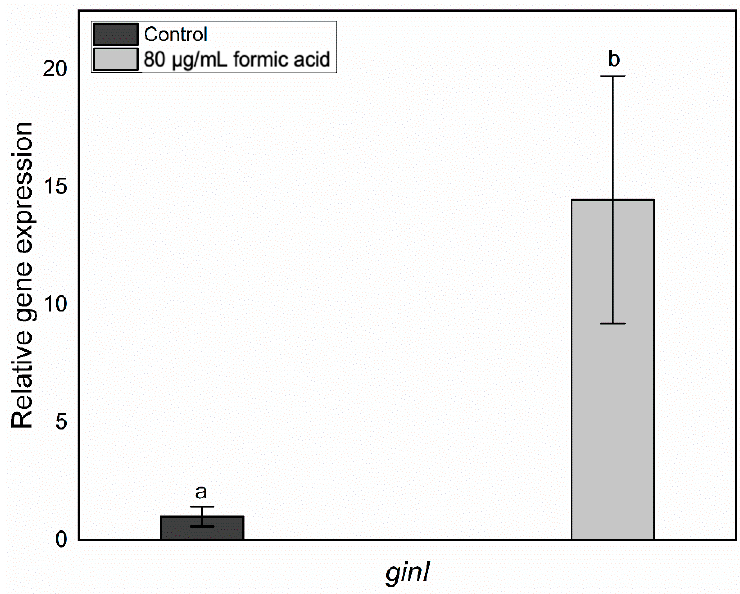
Figure 2. Effect of formic acid (80 µg/mL) on the gene expression of ginI in K. xylinus 700178. Each value is expressed as mean ± standard deviation ( n = 3). Different superscripts are significantly different ( p < 0.05).